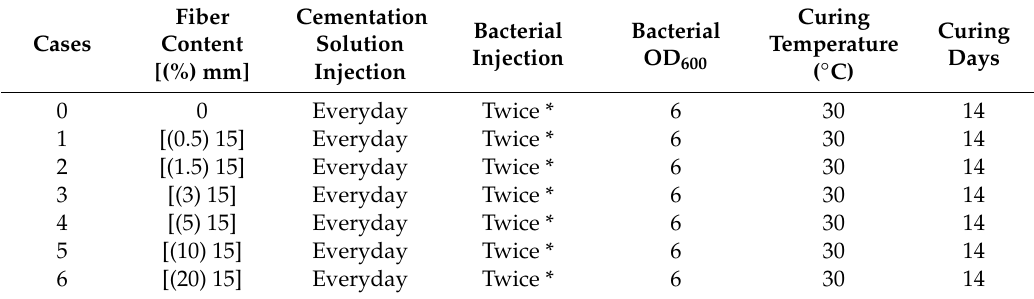
Figure 5. Sample preparation and test setup for the microbial-induced carbonate precipitation (MICP) process with the addition of jute fibers. Table 4. Testing conditions for the sand solidification test (syringe) considering fiber content (%).